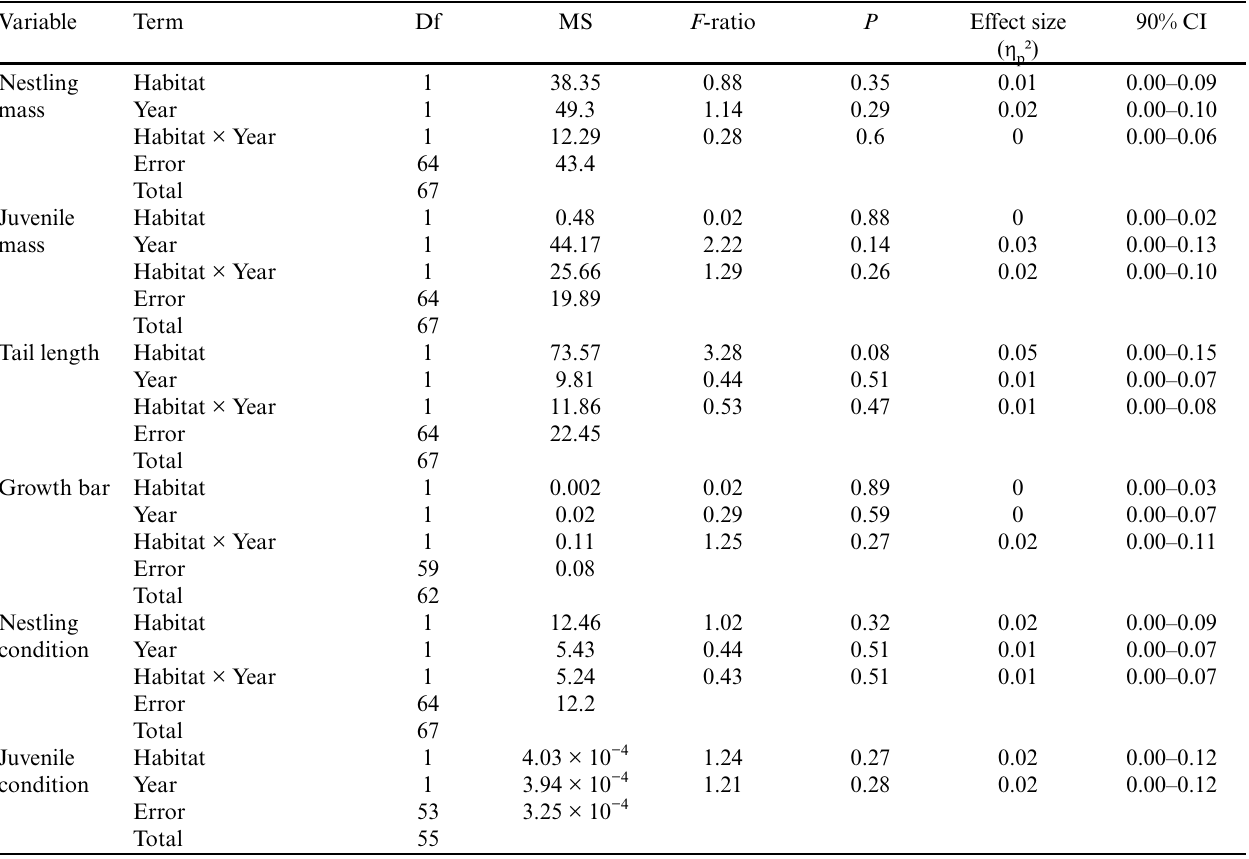
Table 1. Morphometric and condition differences between a suburban and a wildland population of Florida Scrub-Jay juveniles.